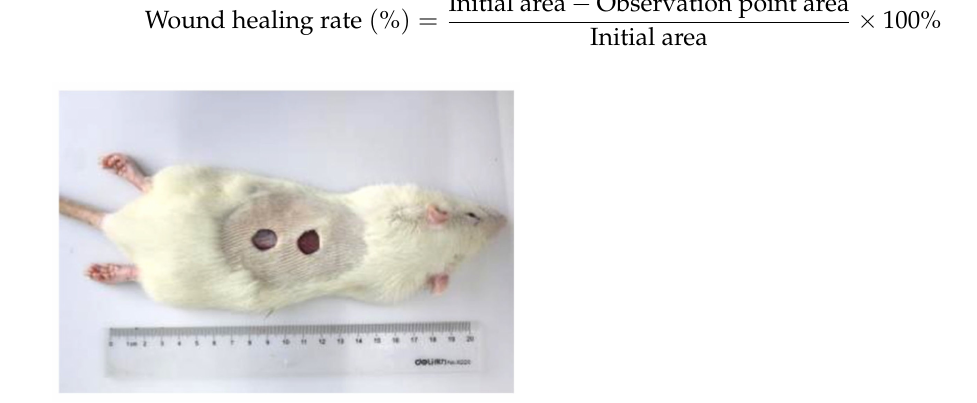
Figure 2. Construction of rat wound model.